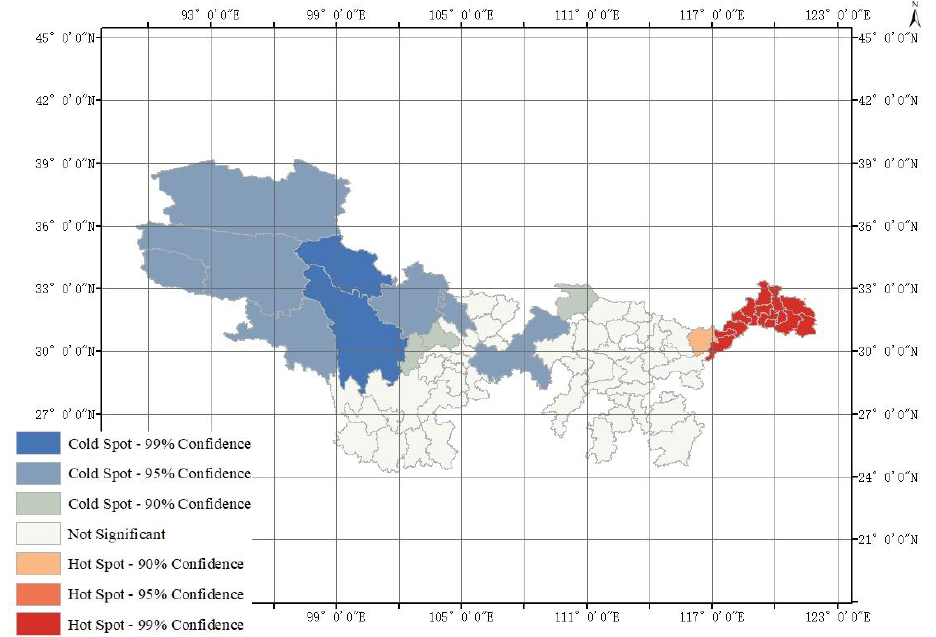
Figure 4. Hot Spot Analysis of CO 2 Emissions in the main stream of Yangtze River (2019).